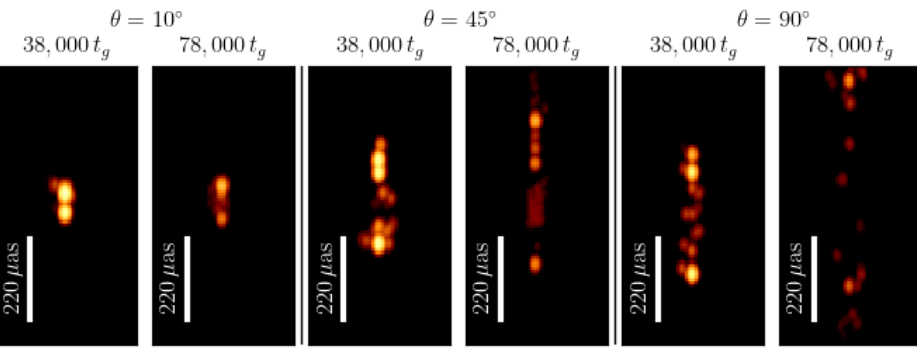
Figure A2. The same as Figure A1 but showing the reconstructed images. Note that the intensity scale for each panel is the same as the corresponding panel in Figure A1 for comparison.